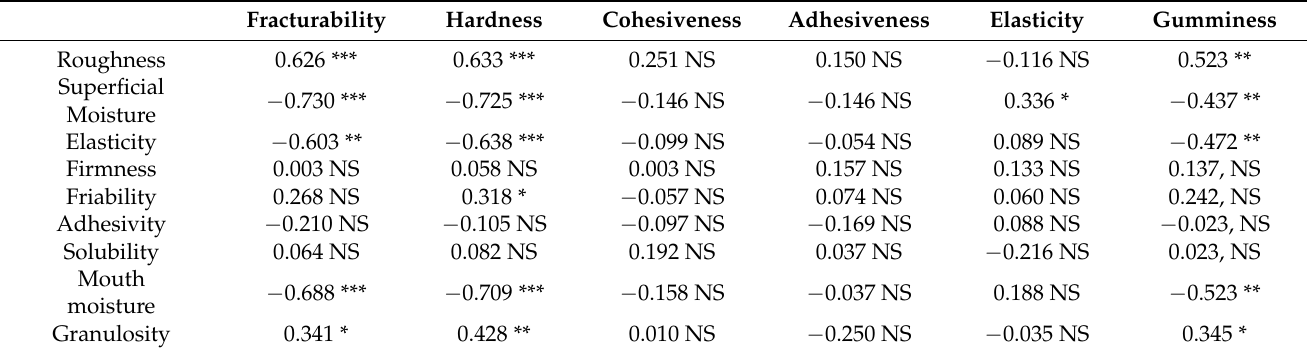
Table 4. Correlation analysis of sensorial terms and instrumental parameters for assessment of cheese texture.